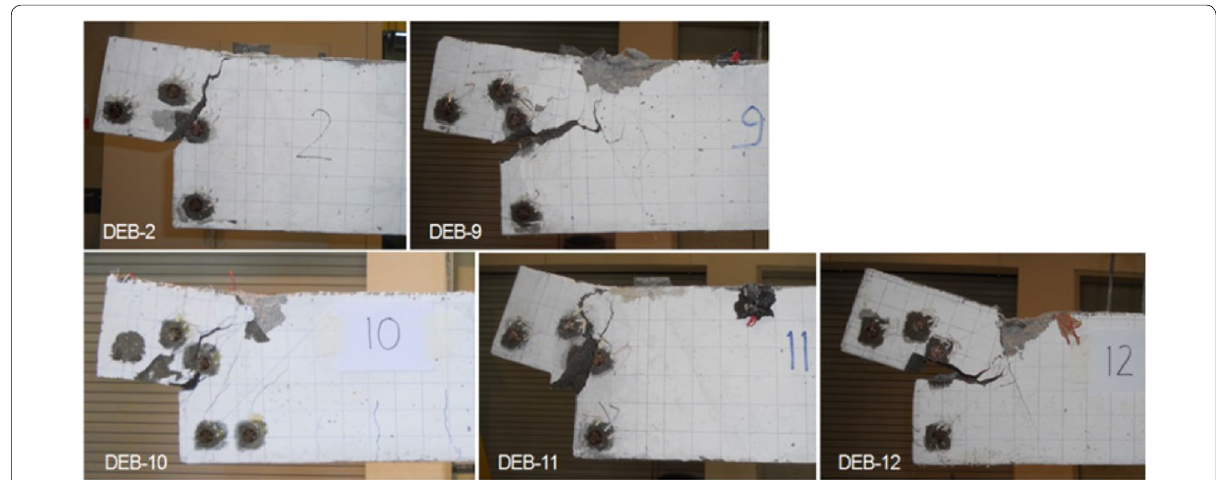
Fig. 12 The beam condition after testing (For DEB-2,-9,-10,11 and DEB-12).